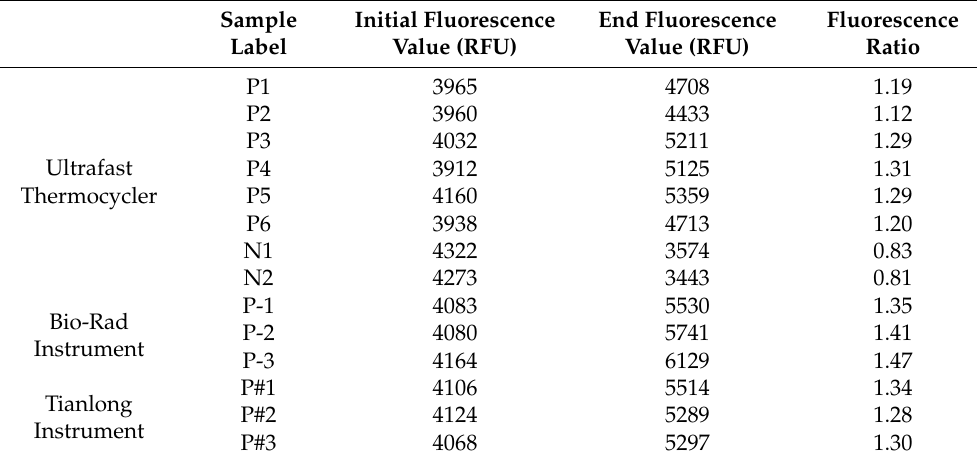
Table 4. Fluorescence detection results before and after nucleic acid amplification.